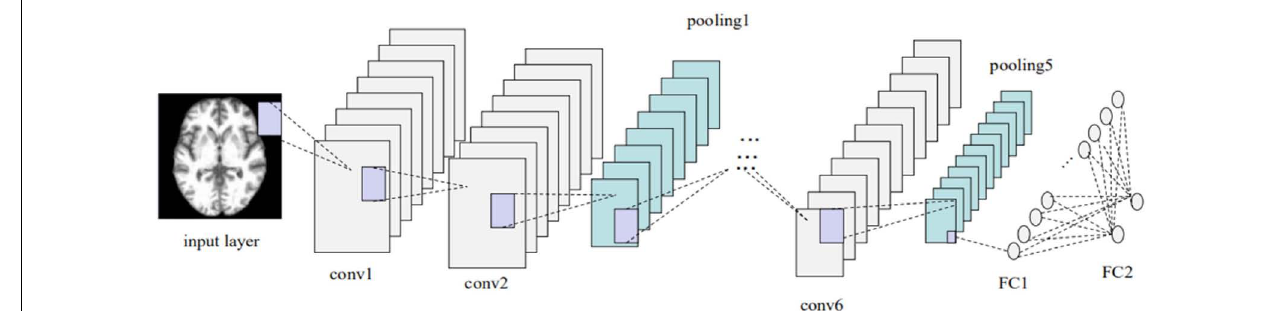
FIGURE 6 | Base-classifier architecture used in the CNN-EL approach proposed here.